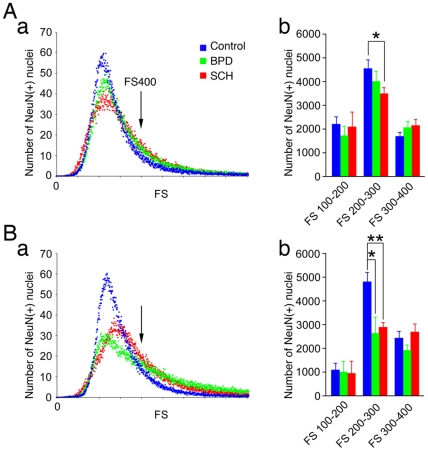
Distribution of FS values of NeuN(+) nuclei (10,000 nuclei) in the gray matter tissue.(A) FPC, (B) ITC, (a) Abnormal distributions of FS values of NeuN(+) nuclei. (b) Abnormal reductions of the small NeuN(+) nuclei counts (FS 200 – 300) in SCH and BPD. * P<0.05, **P<0.01, unpaired t-test. mean±s.e.m.